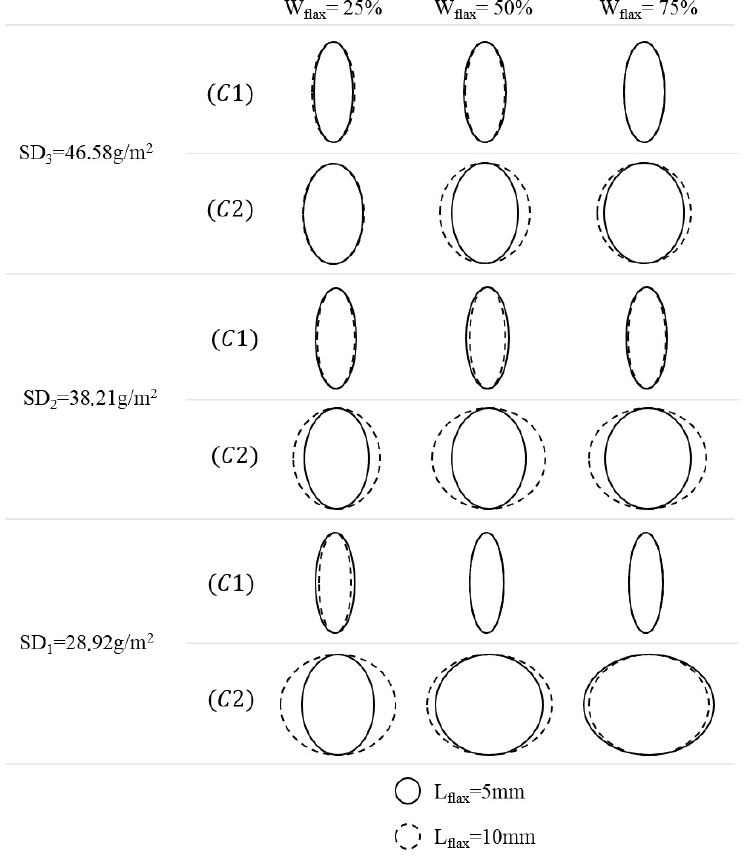
Figure 12. Predicted reinforcement flow front shapes.